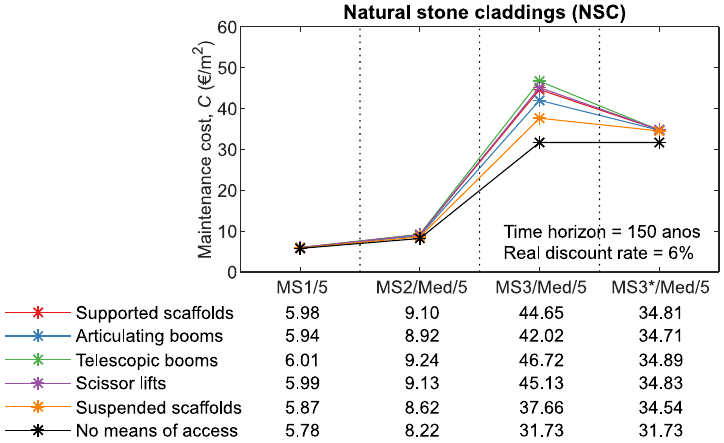
Figure 3. Sensitivity analysis of the different means of access in NSC maintenance strategy costs for a time horizon of 150 years.